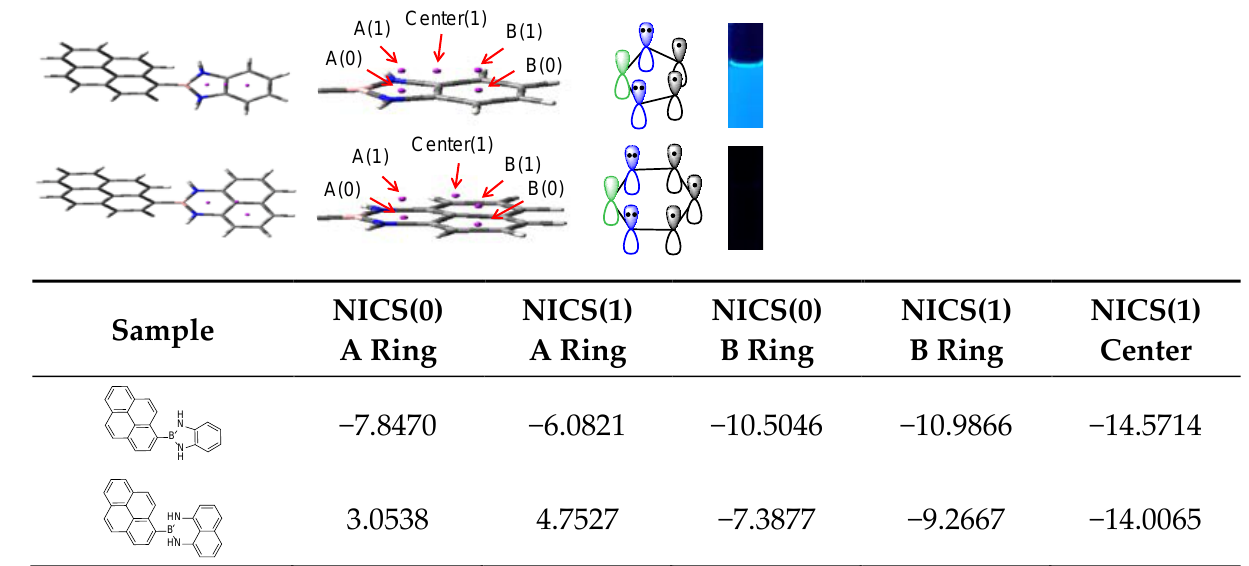
idine by 1 H NMR. Upon addition of increasing amount of pyridine (up to 20 equiv) to a